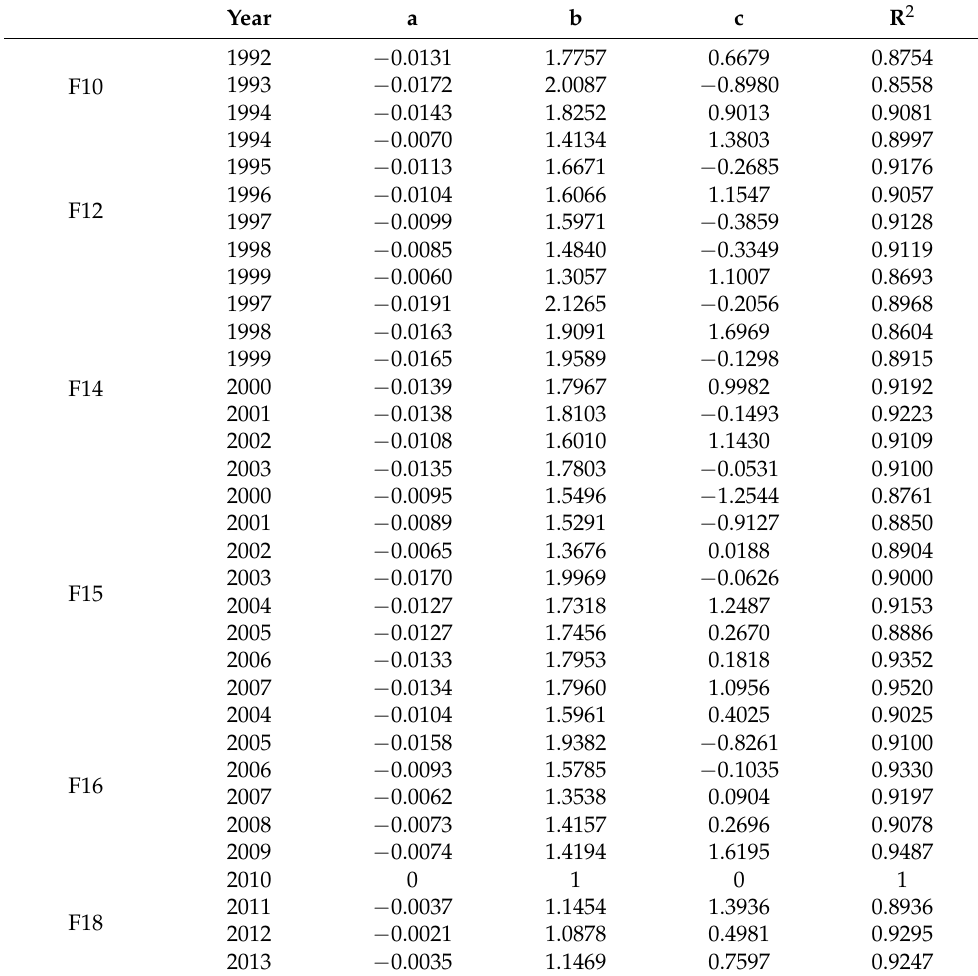
Table 2. Adjusted parameters based on Equation (1) in Sicily using F182010.